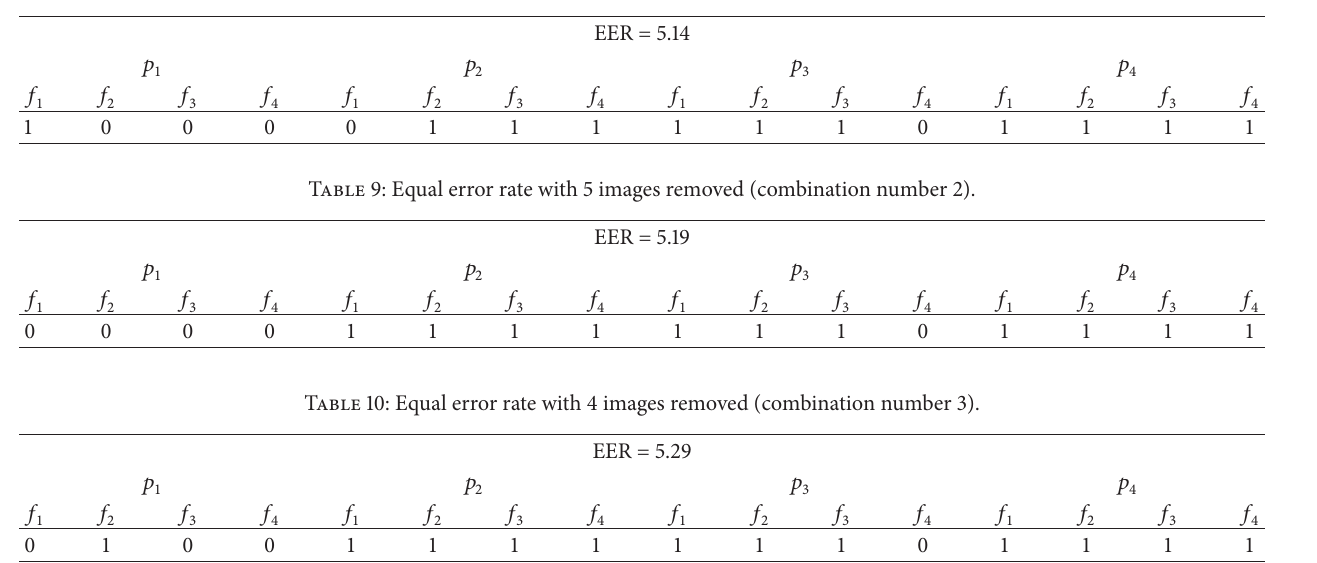
Table 8: Equal error rate with 5 images removed (combination number 1).